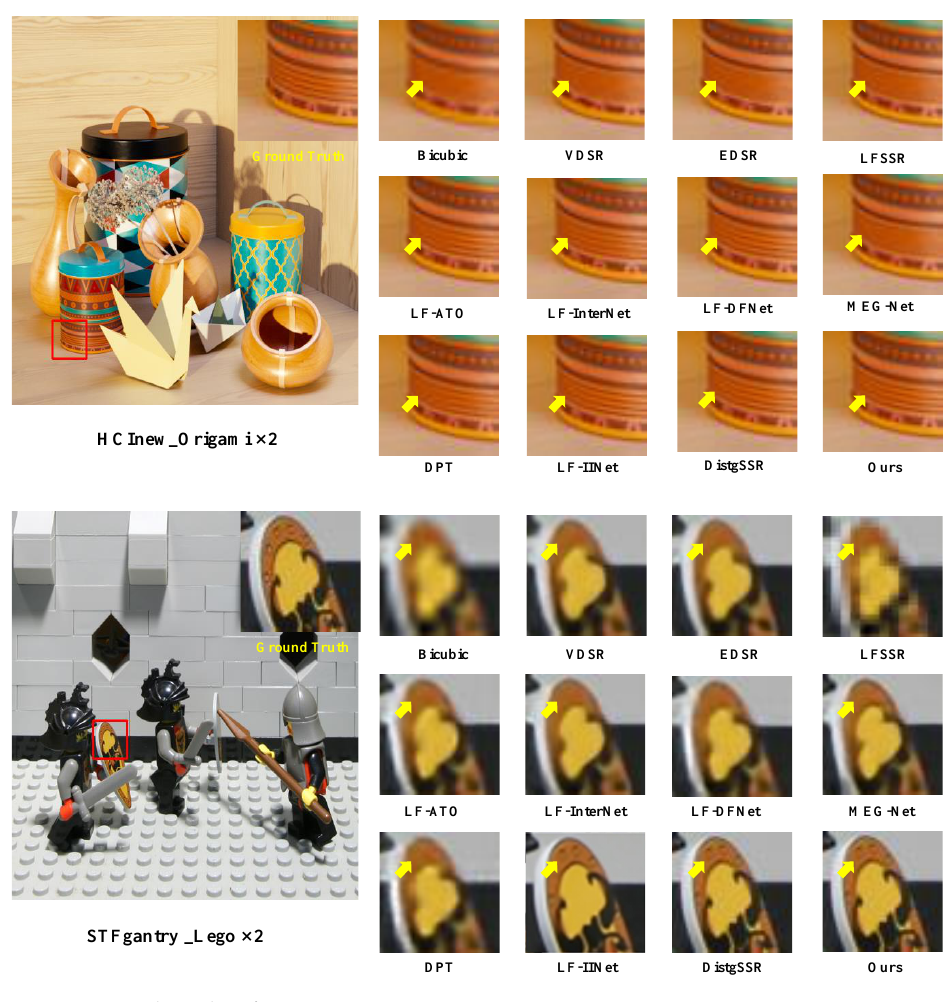
Figure 8. Visual results of 2 ×